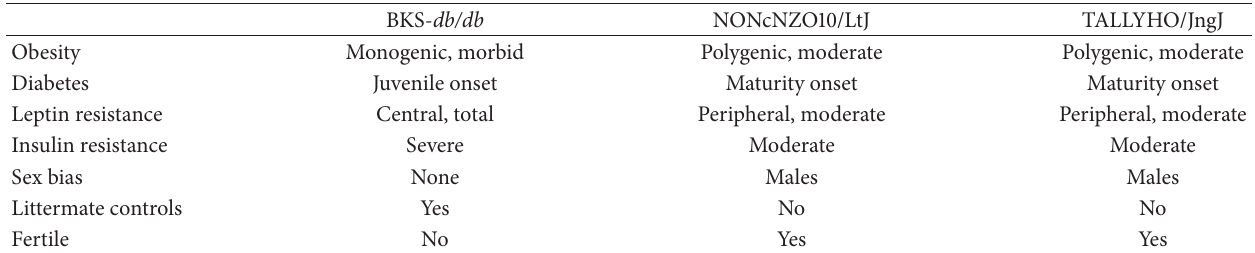
Table 2: Summary comparison of the 3